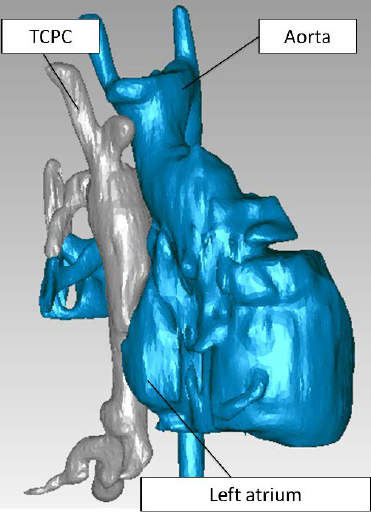
Figure 3. The TCPC ( gray ) and the surrounding heart and blood vessels ( blue ). TCPC: total cavopulmonary connection.